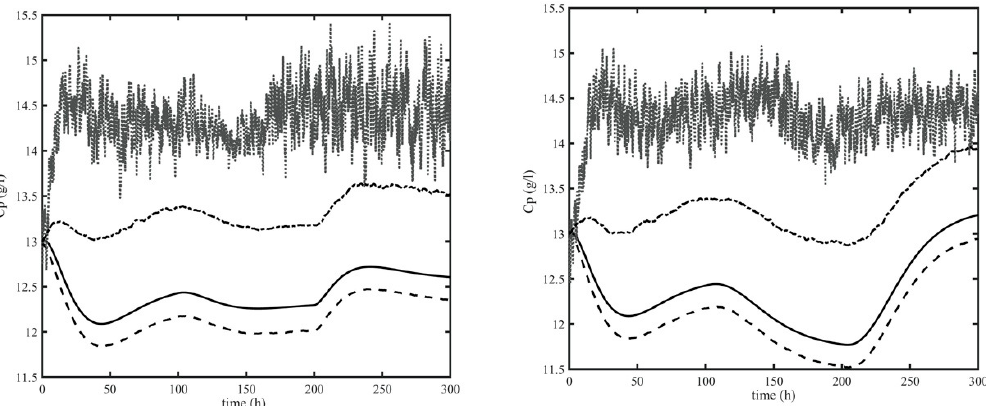
Figure 5. Dynamic response of the biomass concentration calculated with the virtual plant (continuous black line), GO with map φ p3 (dashed dark grey line), GO φ p4,1 (dotted black line), GO with map φ p4,2 (dashed-dotted grey line) along the trajectory T1 ( left panel) and T2 ( right panel).